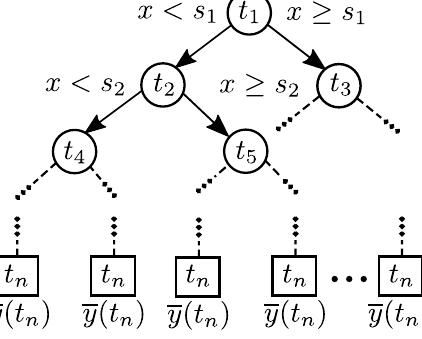
Figure 2. General diagram of a